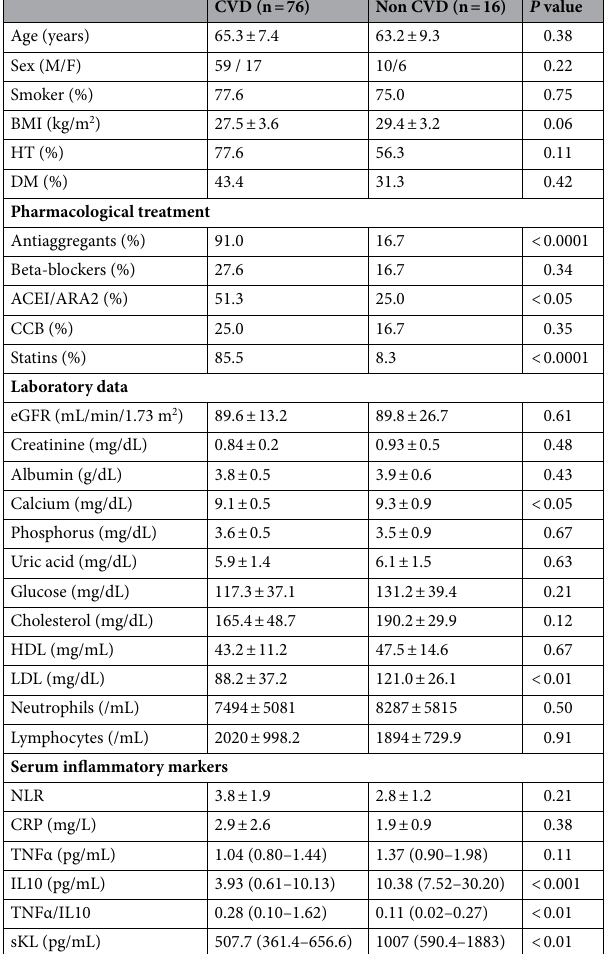
Table 1. Clinical characteristics and biochemical assessments of the patients included in the study. ACEI/ ARA2 Angiotensin converting enzyme inhibitor/angiotensin receptor antagonist 2; BMI Body mass index; CCB Calcium channels blockers; CRP C-reactive protein; DM Diabetes mellitus; eGFR Estimated glomerular filtration rate; HDL High-density lipoprotein; HT hypertension; IL10 Interleukin 10; LDL Low-density lipoprotein; NLR Neutrophil-to-lymphocyte ratio; TNFα Tumor necrosis factor